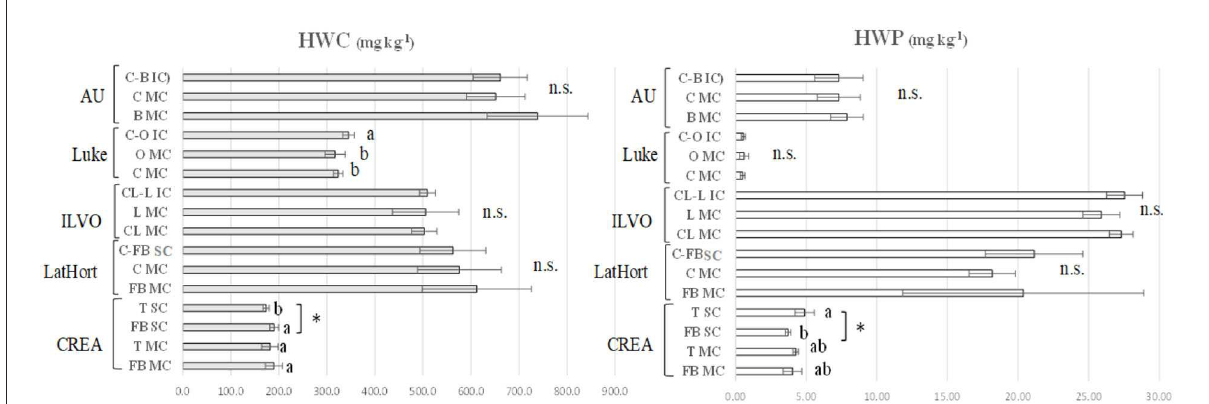
FIGURE3 Soil HWC and HWP (mg kg − 1 ) in: monocropped faba bean (FB MC) and tomato (T MC), strip cropped faba bean (FB SC) and tomato (T SC) at CREA; monocropped faba bean (FB MC) and cabbage (C MC), strip cropped faba bean and cabbage (FB-C IC) at LatHort; monocropped celeriac (CL MC) and leek (L MC), intercropped celeriac and leek (CL-L IC) at ILVO; monocropped cabbage (C MC) and onion (O MC), intercropped cabbage and onion (C-O IC) at Luke; monocropped beetroot (B MC) and cabbage (C MC), and intercropped beetroot and cabbage (B-C IC) at AU. Levels of statistical significance ( p value) are: * p < 0.05, ** p < 0.01, and *** p < 0.001, ns = not significant (ANOVA). Different letters represent significant differences (Tukey’s HSD test for means comparison).